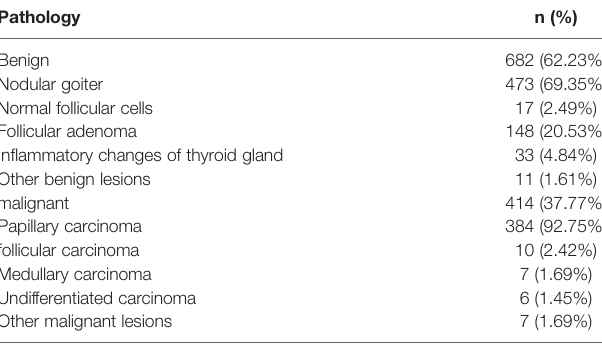
TABLE 1 | Pathological results of 1096 thyroid